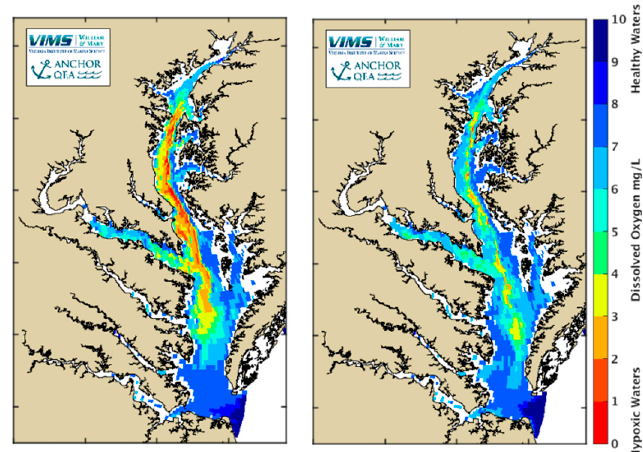
Figure 2. Bottom oxygen nowcast (left panel) from 24 July 2018 and bottom oxygen forecast for 26 July 2018 during a period of high precipitation that caused some minor flooding along the upper and middle Chesapeake Bay regions. Hypoxia forecasts provide a useful result that supports users that are interested in the extent, duration, and severity of low-oxygen dead zones in the Chesapeake Bay. For more detail, see http://www.vims.edu/research/topics/dead_zones/forecasts/cbay/index.php. Public Domain Figure.